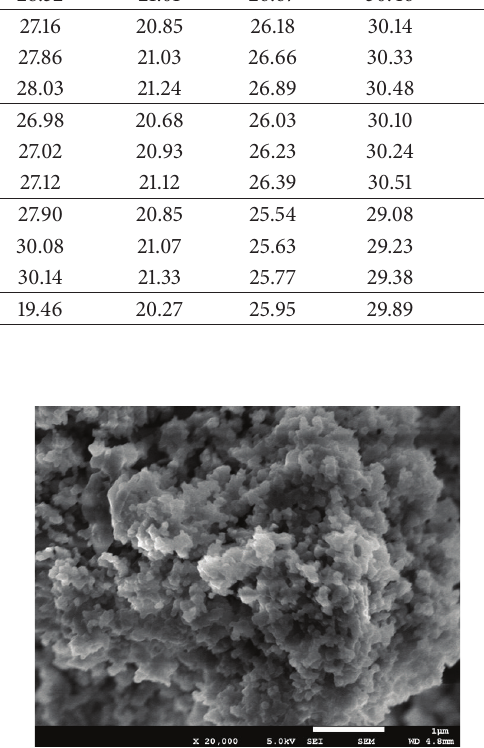
Figure 8: FESEM photography of ambient-cured OPSGPC incor- porating pretreated OPS with PVA.